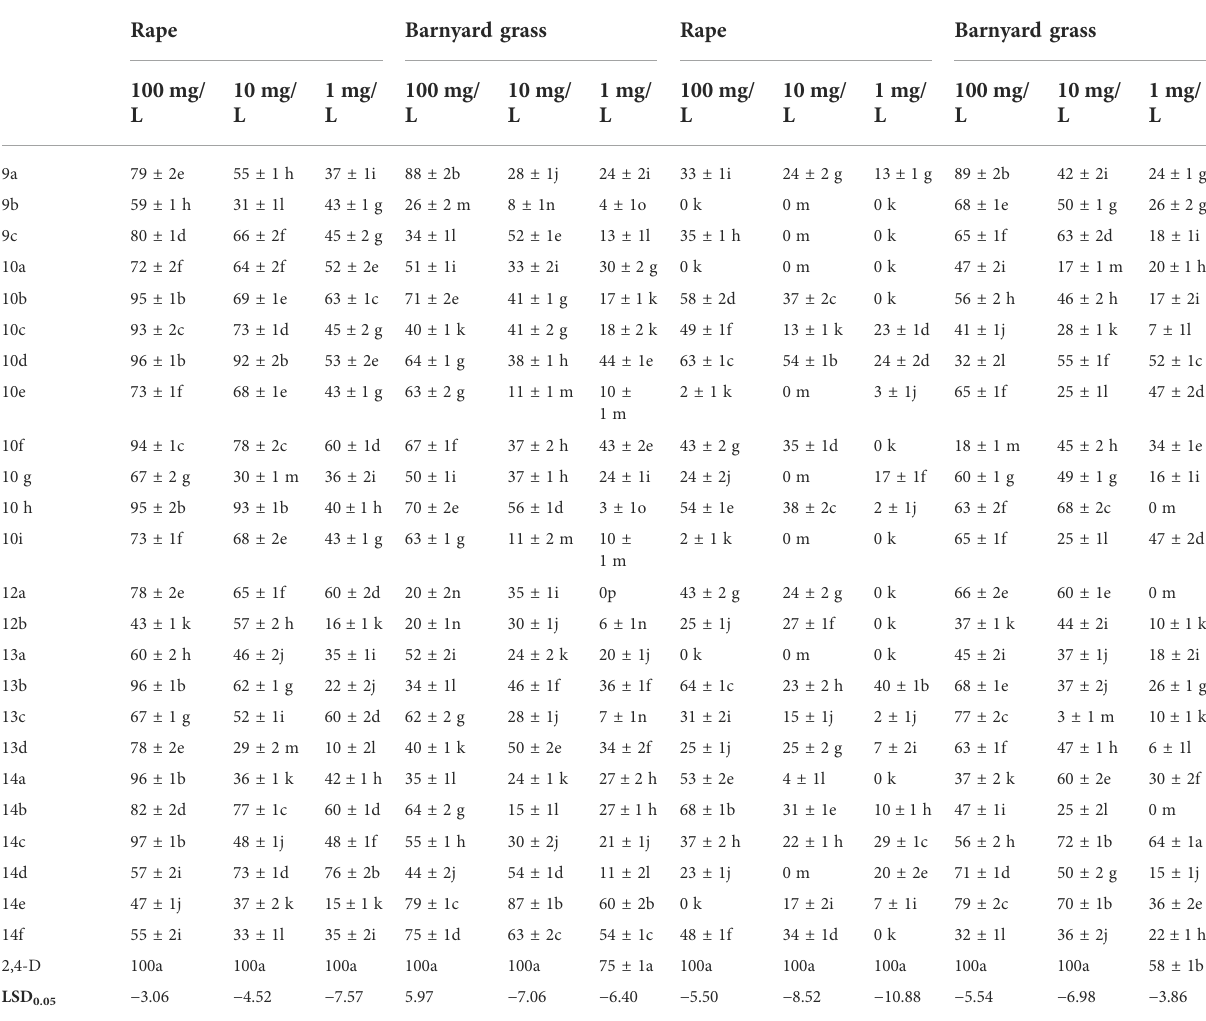
TABLE 1 Results of Petri dish herbicidal activity test of indole-3-carboxylic acid derivatives. Compound Average root inhibitory rate (%)